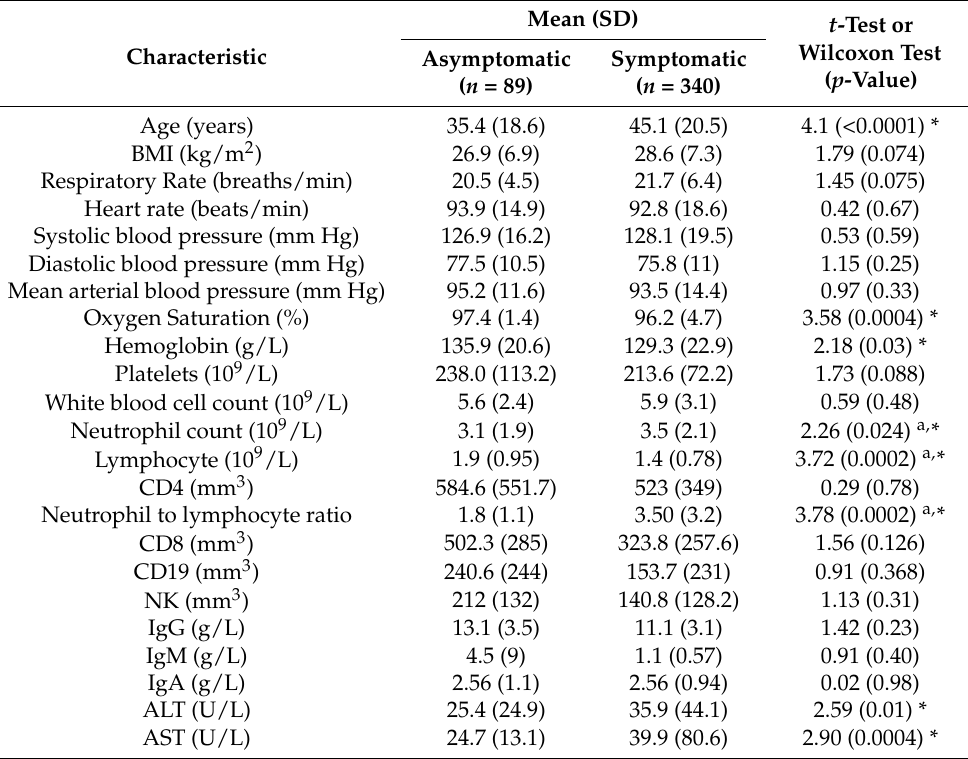
Table 2. Continuous demographic and clinical characteristics assessed by symptomatic vs. asymp- tomatic status. Mean (SD) t -Test Characteristic